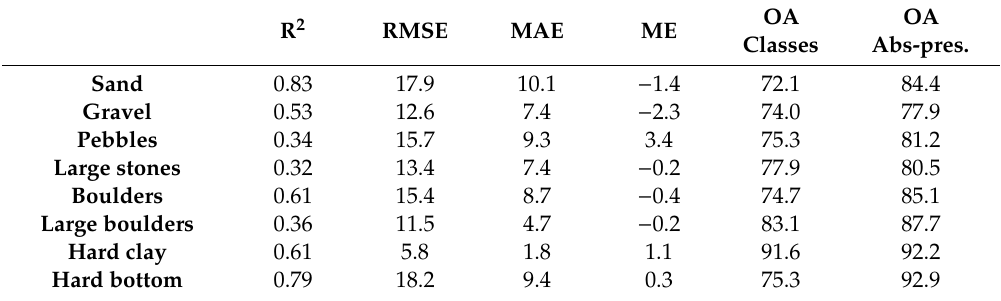
Table 10. Accuracy of percent coverage substrate components (individual models adjusted to sum to 100%), divided into groups. Accuracy was measured (testing data, observed vs. predicted) with mean error (ME) and standard deviation (SD).